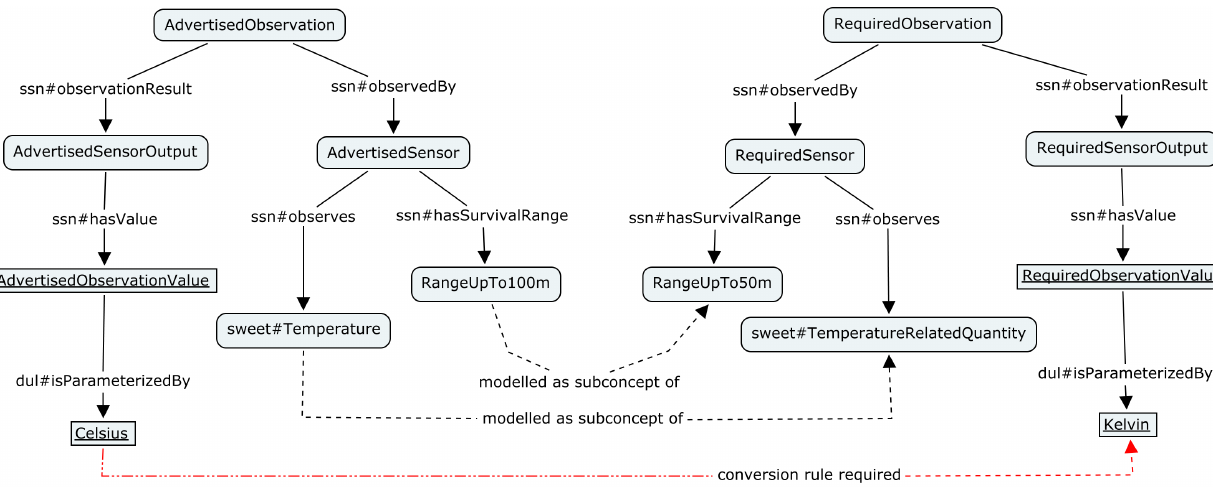
Figure 12. Created concepts for the req sensor and the adv